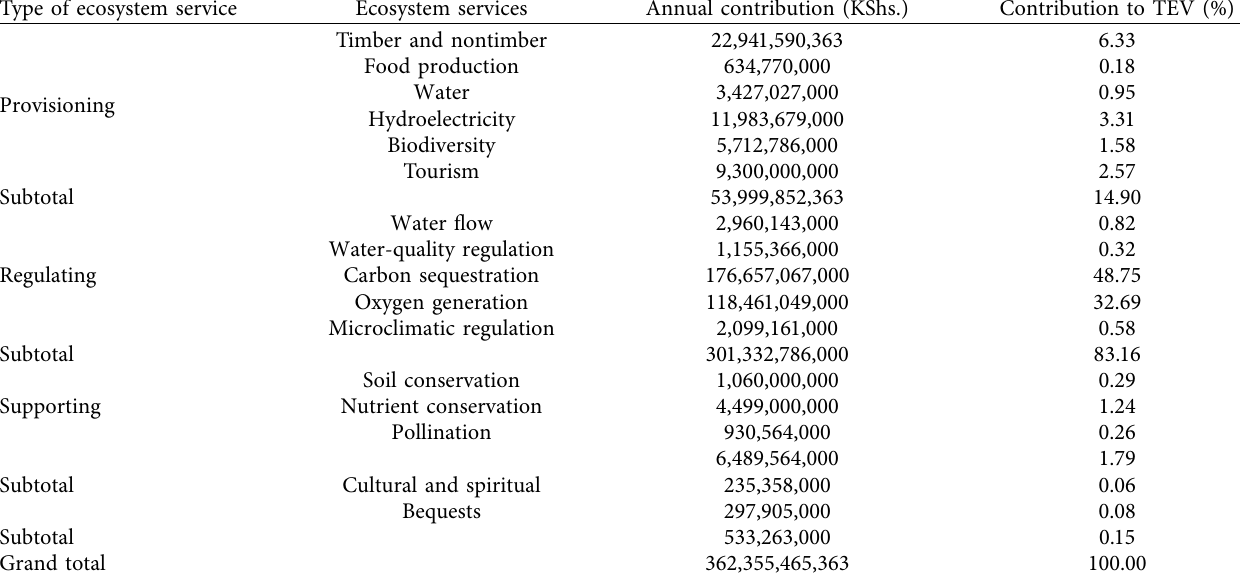
Table 4: Total economic value of the Mau, Cherangany, and Mt. Elgon ecosystems. Type of ecosystem service Ecosystem services Annual contribution